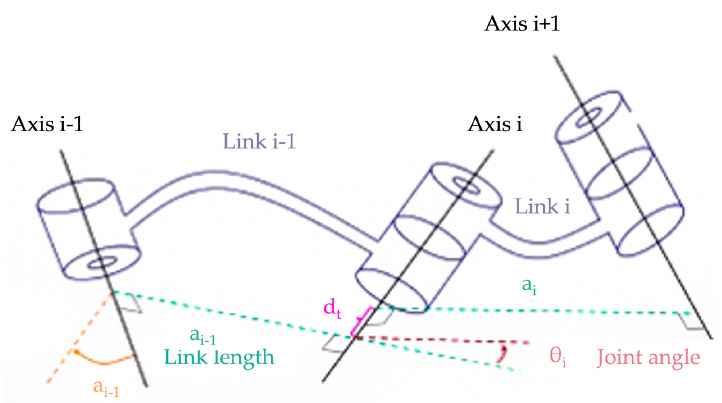
Figure 5. The D-H model.